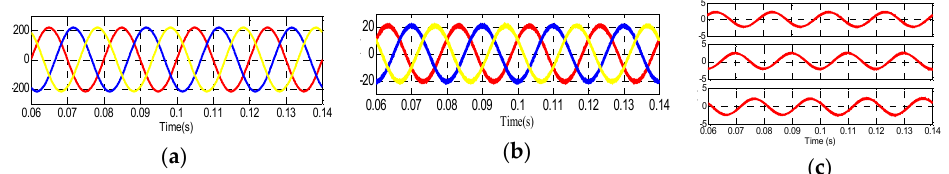
Figure 7. Simulation results of the reconfigurable inverter under faulty phase a: ( a ) output voltages; ( b ) currents; ( c ) voltage deviations.